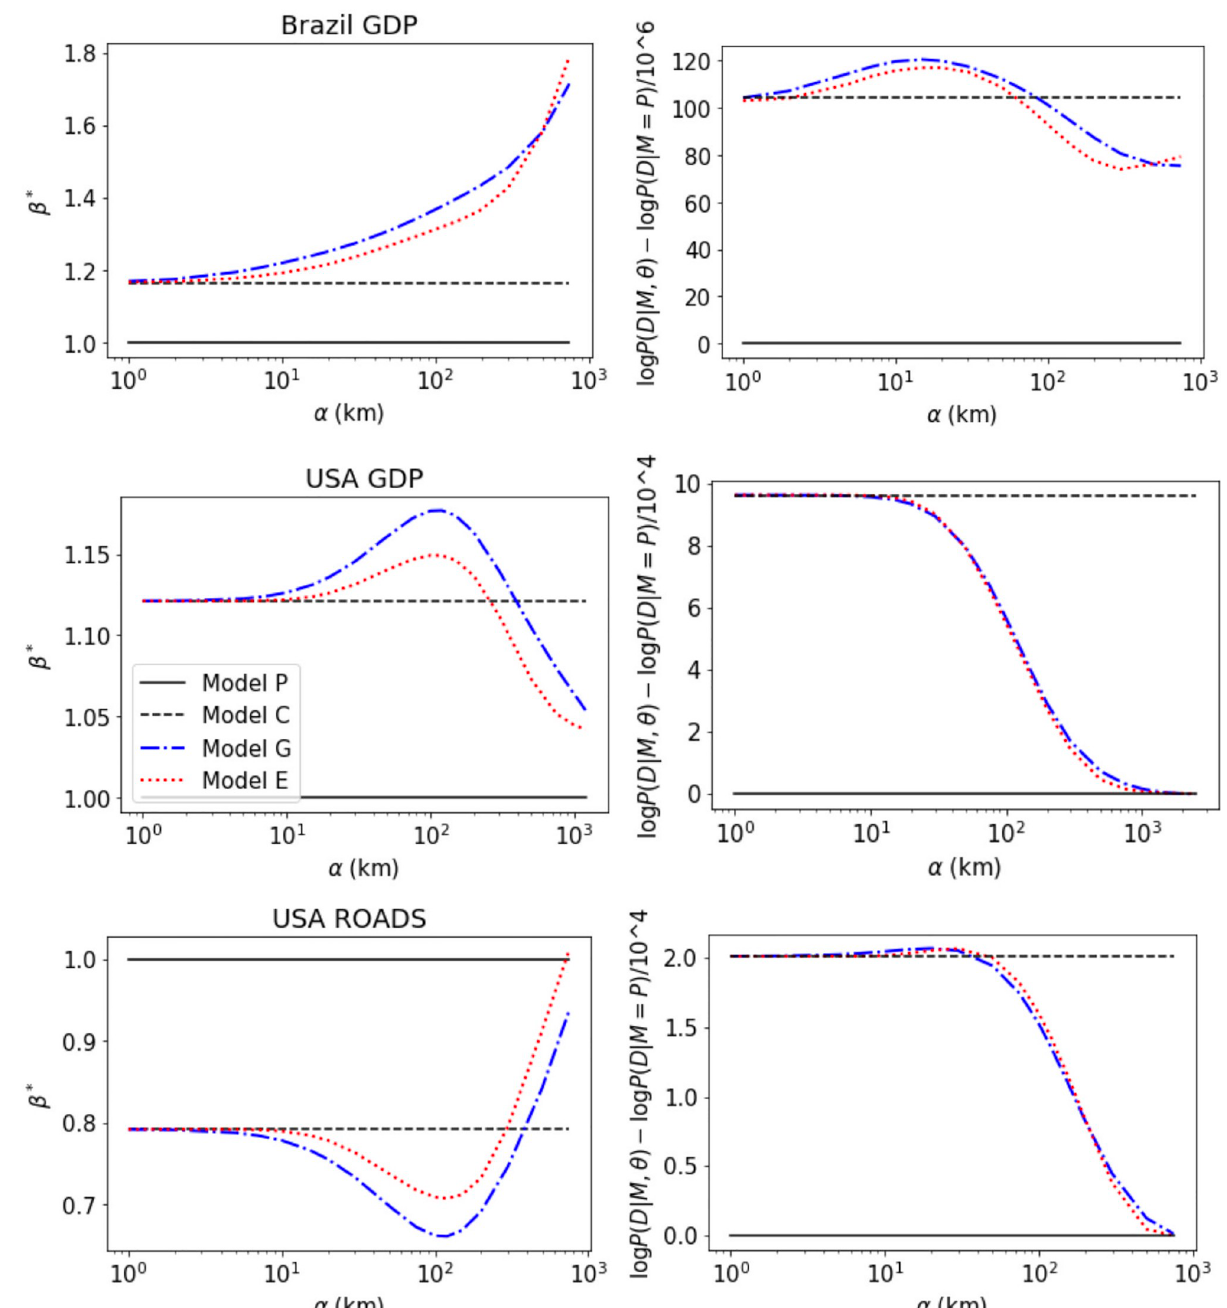
Fig 2. Spatial dependence affects the choice of the scaling parameter β . The value of α (measured in kilometres) is varied and the most likely value of β is estimated for each α . The three left panels shows the value of β and the three left panels indicate the likelihood L of the different models M indicated in the legend. The panels on the top correspond to GDP data from Brazil, the best model is M = G with α = 14.6 and β = 1.24. The panels on the centre correspond to GDP data from USA, the best model is the city model M = C (obtained for α = 0) with β = 1.12. The panels on the bottom correspond to data from road miles in the USA, the best model (largest likelihood) is M = G with α = 20.4 and β = 0.75.